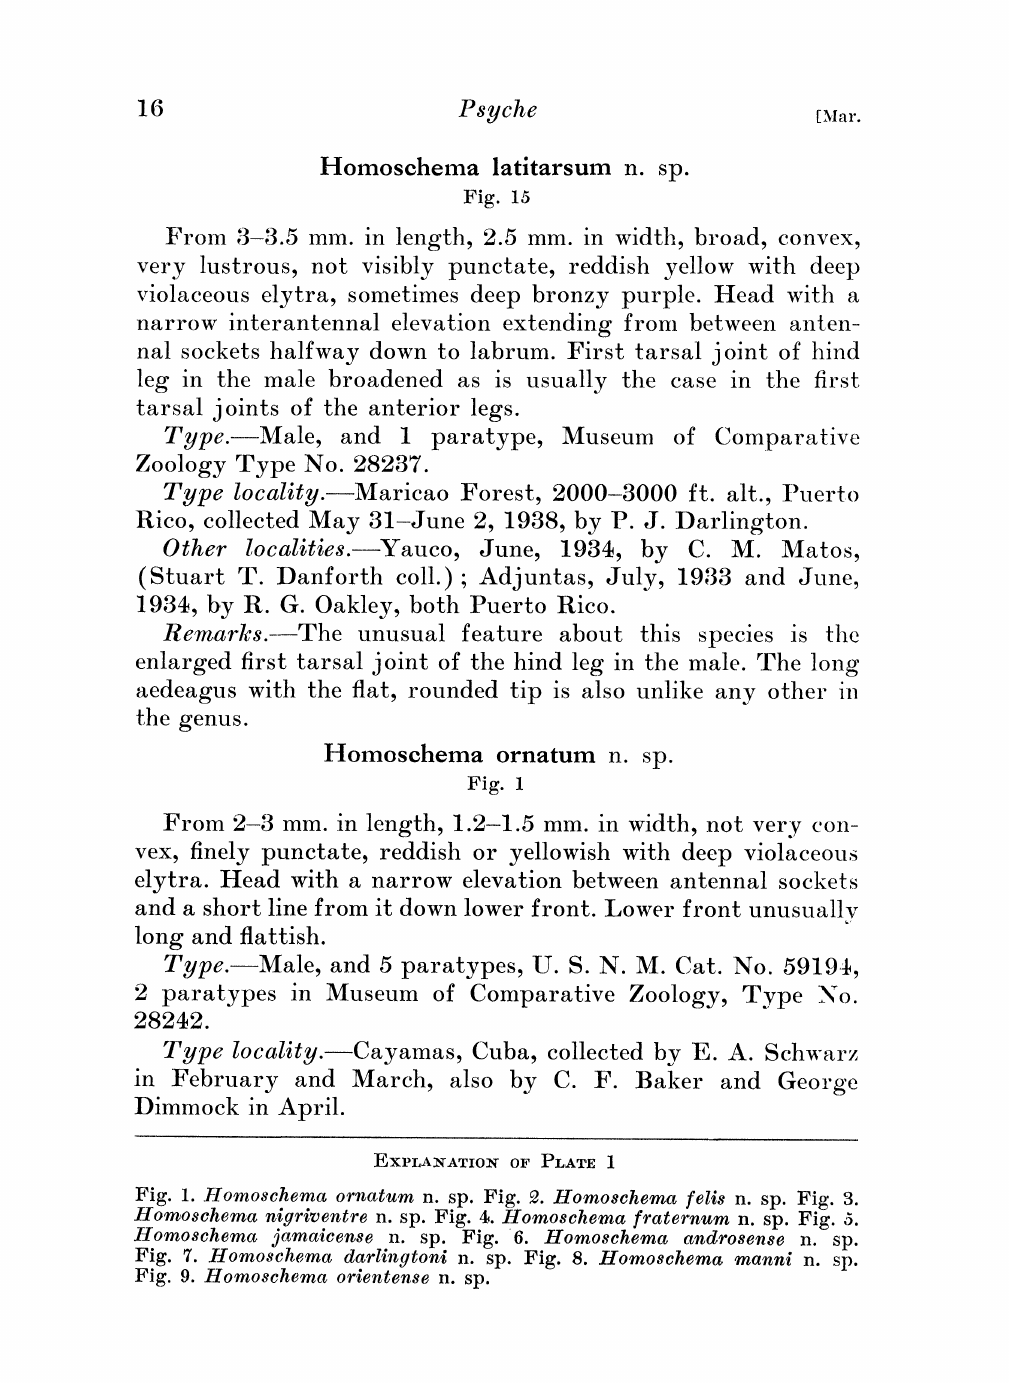
. Fig. 1. Homoschema ornatum n. sp. Fig. 2. Homoschema felis n. sp. Fig. 3. Homoschema nigriventre n. sp. Fig. Homoschema fraternum n. sp. Fig. 5. Homoschema jamaicense n. sp. Fig. 6. ttomoschema androsense n. sp. Fig. 7. Homoschema darlingtoni n. sp. Fig. 8. ttomoschema manni n. sp. Fig. 9. Homoschema orientense n.